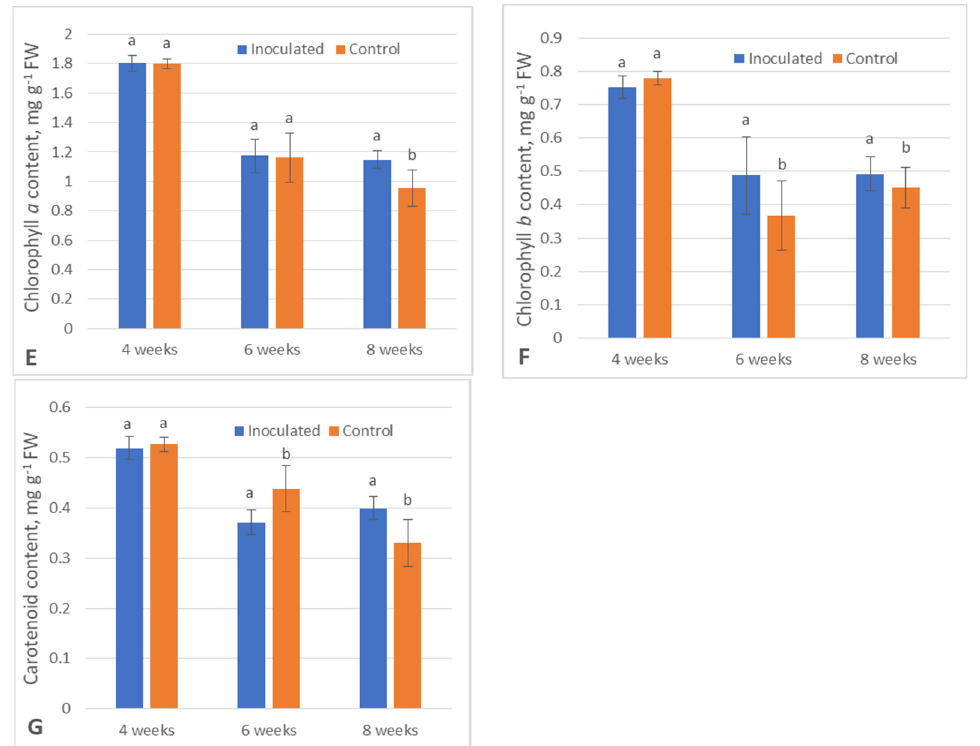
Figure 1. The concentrations of tested bioactive compounds in the control (uninoculated) and Paenibacillus sp. inoculated groups throughout the experiment: ( A )—antioxidant scavenging (DPPH), ( B )—antioxidant scavenging (ABTS), ( C )—total phenolic content (TPC), ( D )—total flavonoid content (TFC), ( E )—chlorophyll a (CHA), ( F )—chlorophyll b (CHB), ( G )—carotenoids (CAR). Different letters above data from each week indicate significantly different results between control and inoculated groups, p ≤ 0.05.